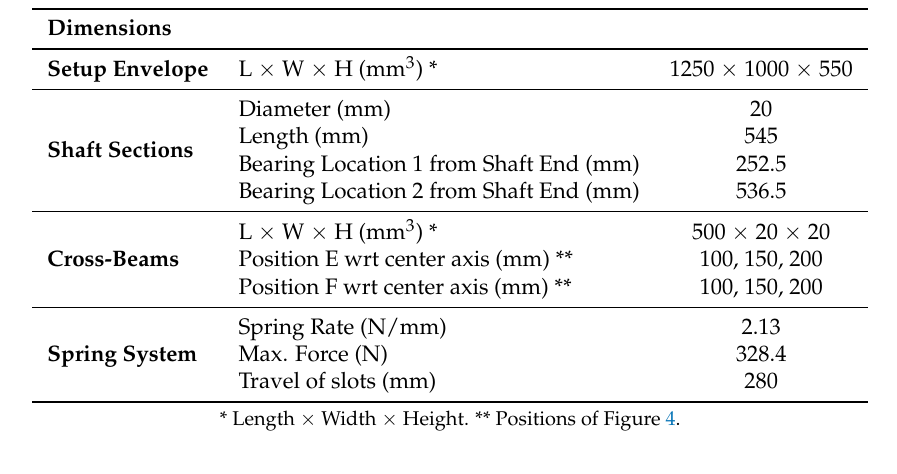
Table 1. Overview of the test rig dimensions.